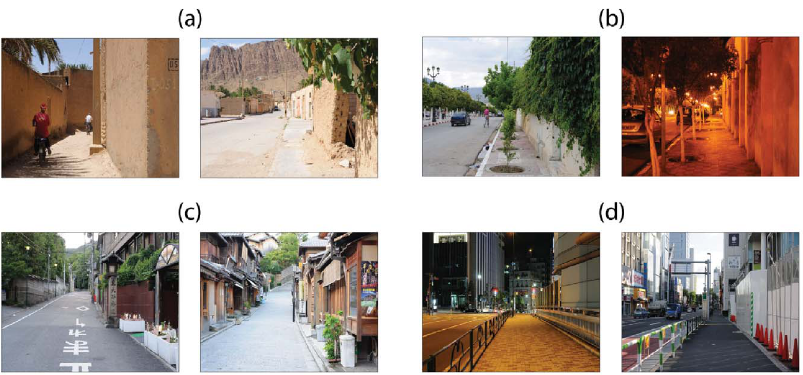
Figure 3. Streetscapes. (a) Al-Kantara. (b) Batna. (c) Kyoto. (d) Tokyo.